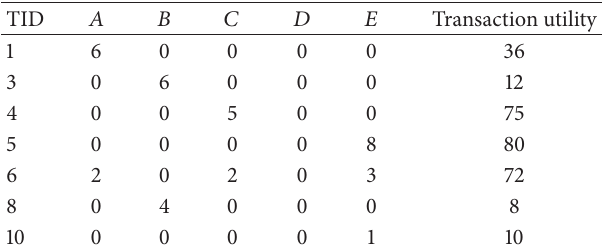
Table 7: The candidate transactions for insertion with their trans- action utilities.